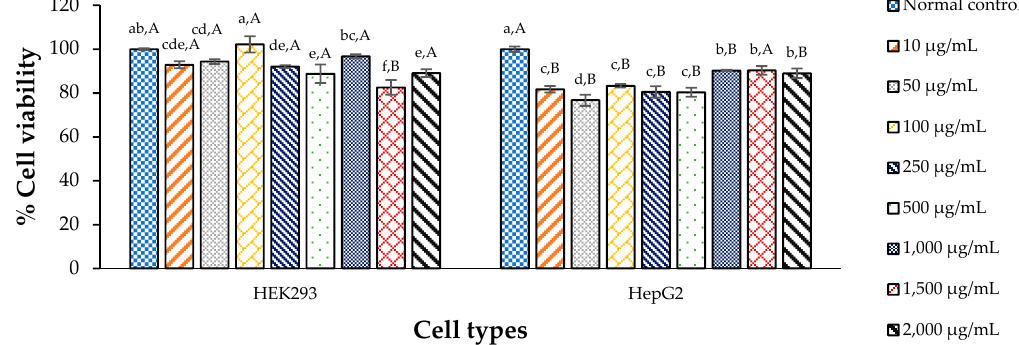
Figure 2. Of the CDE of T. laurifolia leaves on cell viability of HEK293 and HepG2 cells; a–f means with different letters are significantly different within a cell type ( p < 0.05); A,B means within an extract concentration with different letters are significantly different ( p < 0.05); Values are mean ± standard deviation.